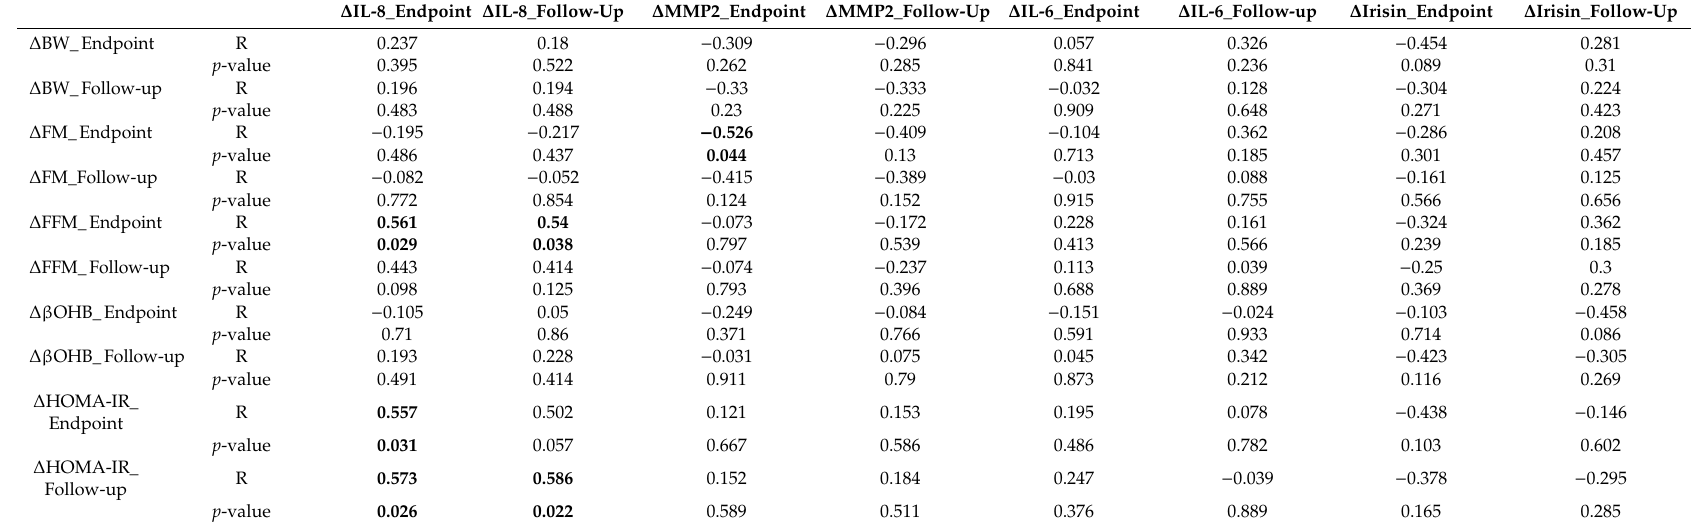
Table 2. Association between changes in myokine levels and body weight, body composition, HOMA-IR, and β -OHB, with respect to baseline following the weight loss treatments, adjusted by types of